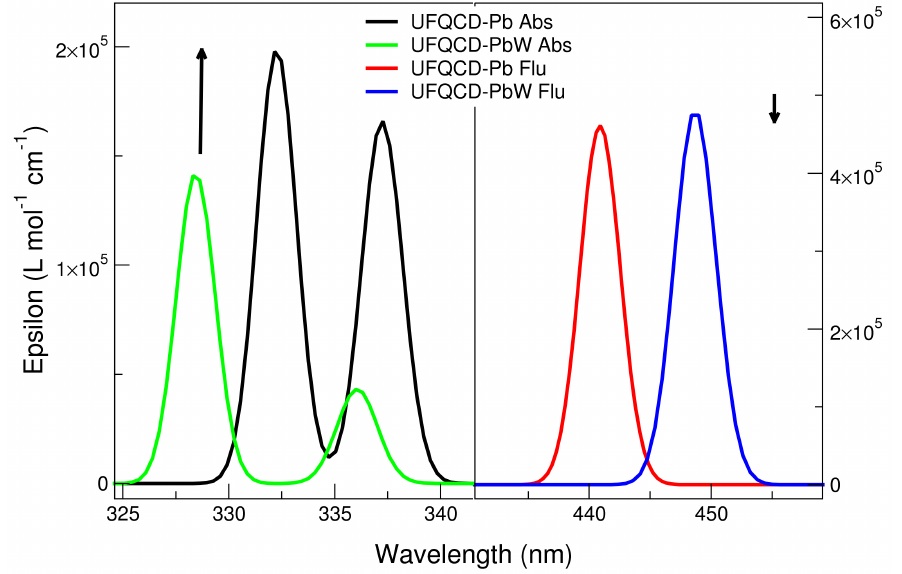
Figure 5. UFQD-Pb absorption ( left ) and emission ( right ) theoretical